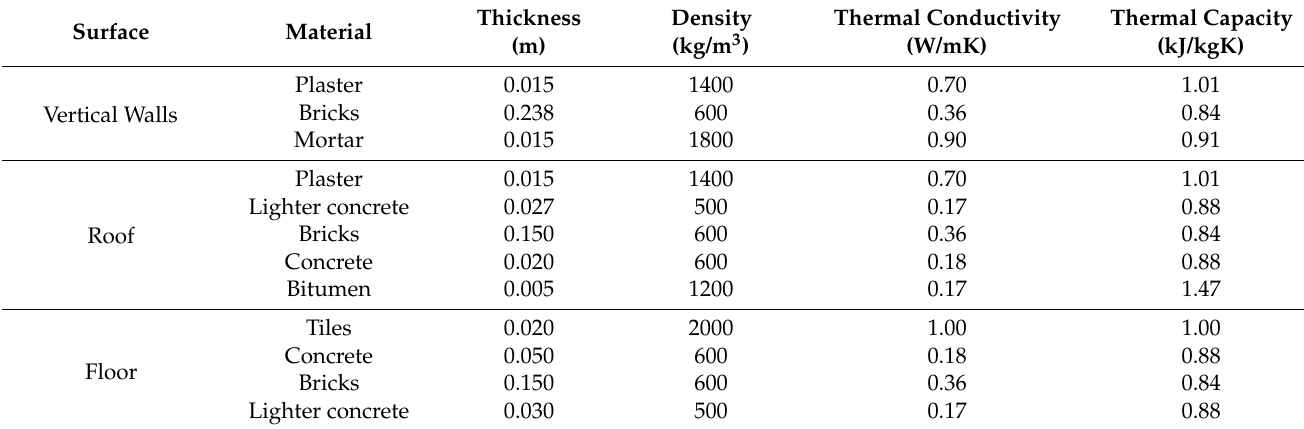
Table 5. Simulation parameters used in this research.